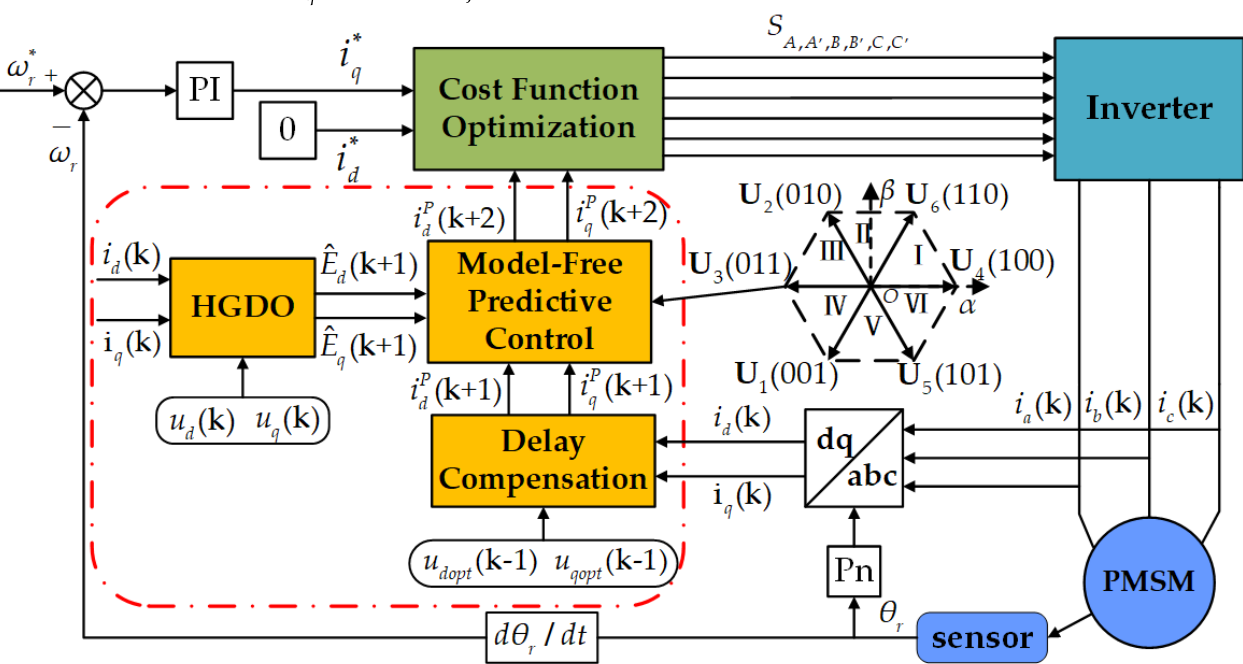
Figure 2. Block diagram of improved model − free predictive control system based on HGDO for PMSM.